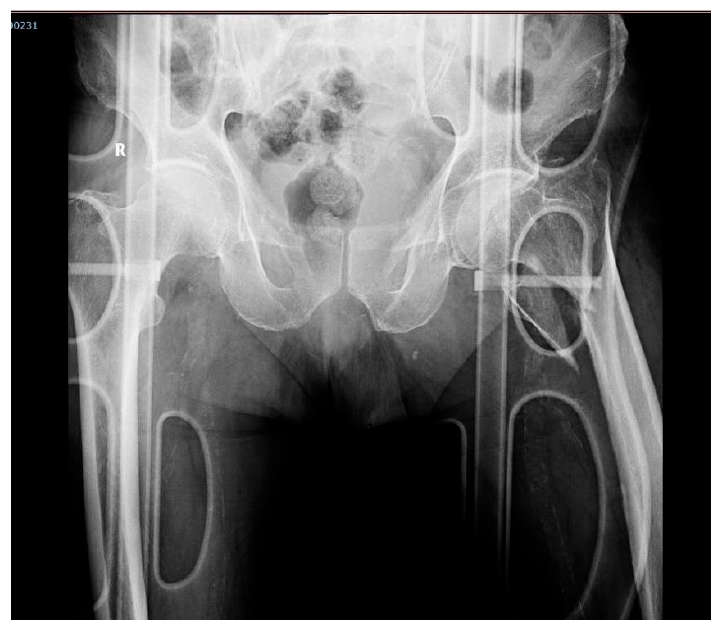
Figure 4. Pelvic X-ray upon arrival, in anteroposterior incidence. Description: Male subject on gurney. Right hip with minimal narrowing of the joint space. Left hip showing a left comminuted femur fracture in the upper 1 / 3 segment, with displaced bone fragments and minimum angulation.